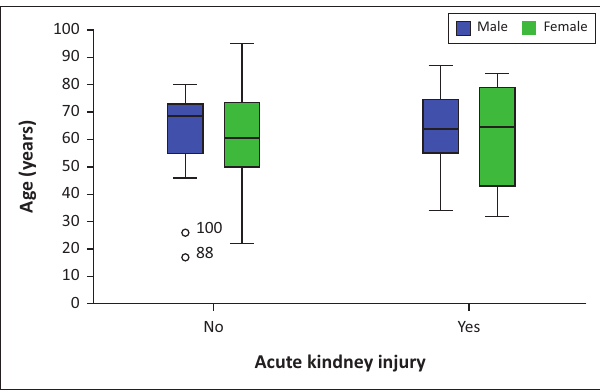
FIGURE 1: Age, gender and acute kidney injury distribution among hospitalised patients who died due to COVID-19.